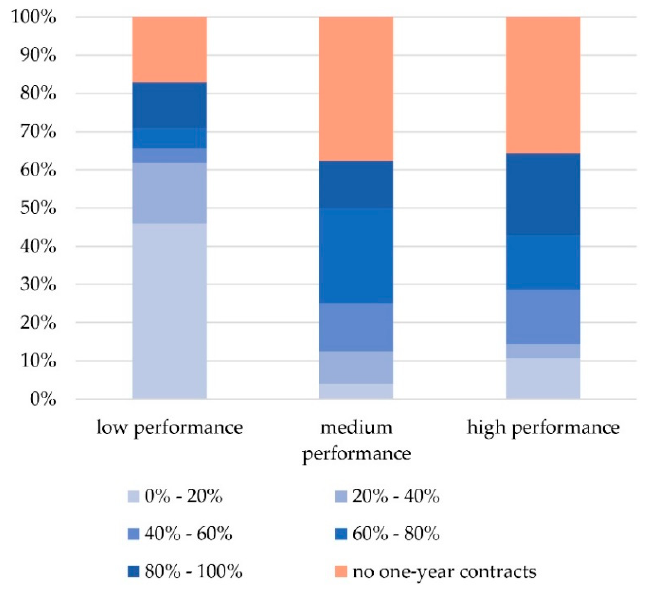
Figure 9. Share of profitability associated with annual contracts by performance category (last six months).